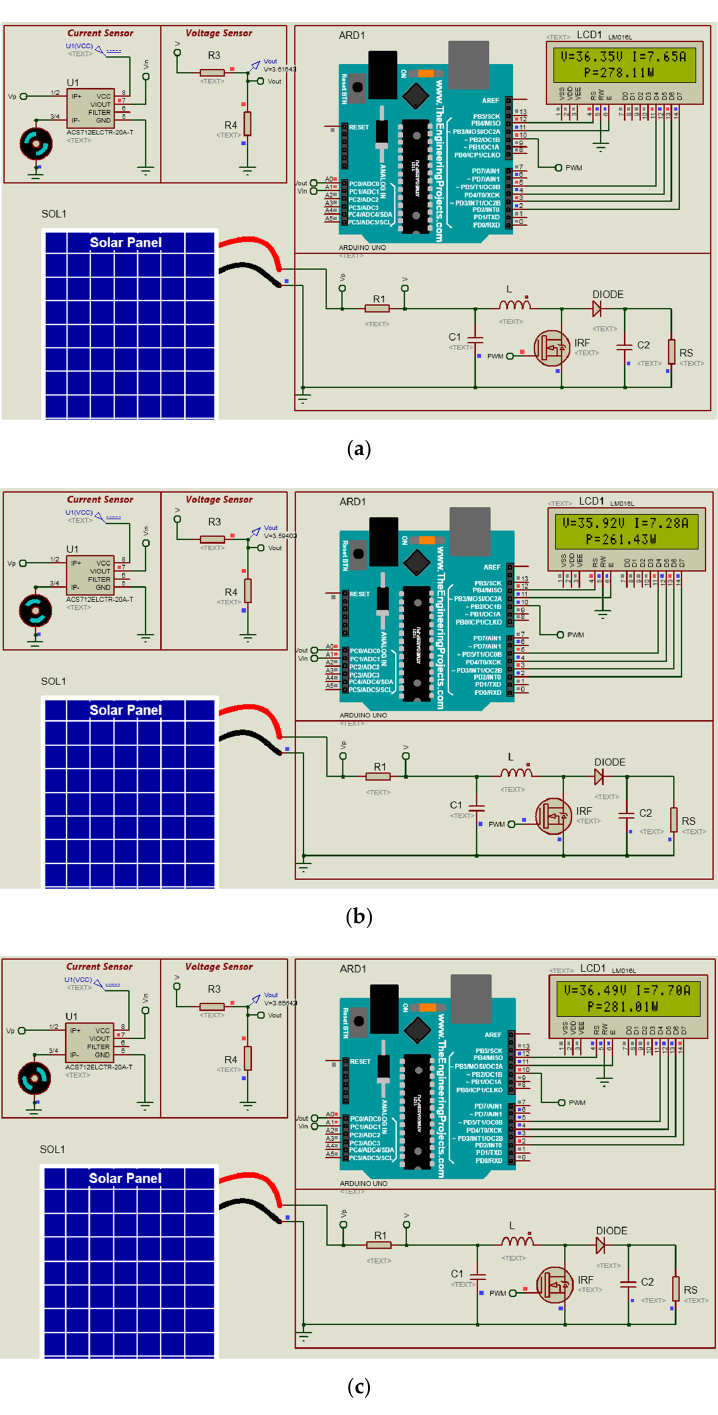
Figure 13. ( a ) PV energy measurement using INC on Proteus-based Arduino. ( b ) PV energy measurement using FLC on Proteus-based Arduino. ( c ) PV energy measurement using modINC on Proteus-based Arduino.